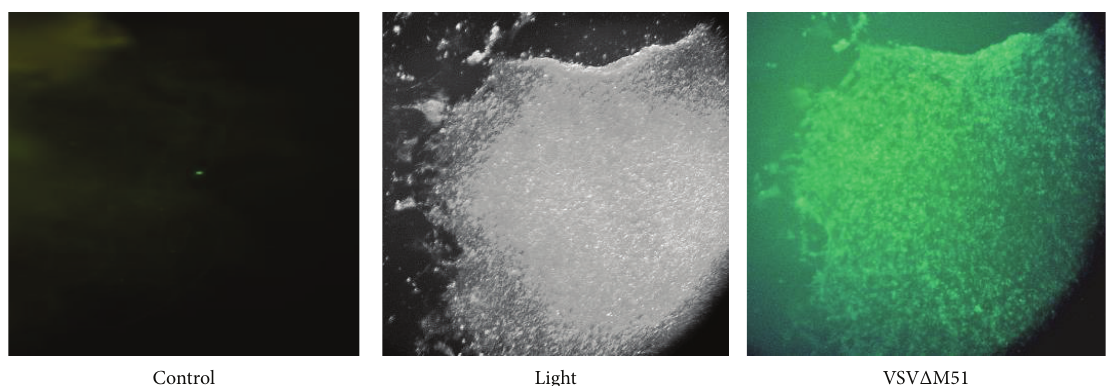
Figure 1: VSV Δ M51 infects primary human Ewing sarcoma specimen obtained from the proximal humerus lesion. The tumor specimen was inoculated with 1 × 10 6 pfu/mL of VSV Δ M51-GFP. GFP expression was monitored using a fluorescent microscope 24 hrs after inoculation and the green fluorescence represents infected cells. Normal adjacent muscle control tissue is resistant to infection.